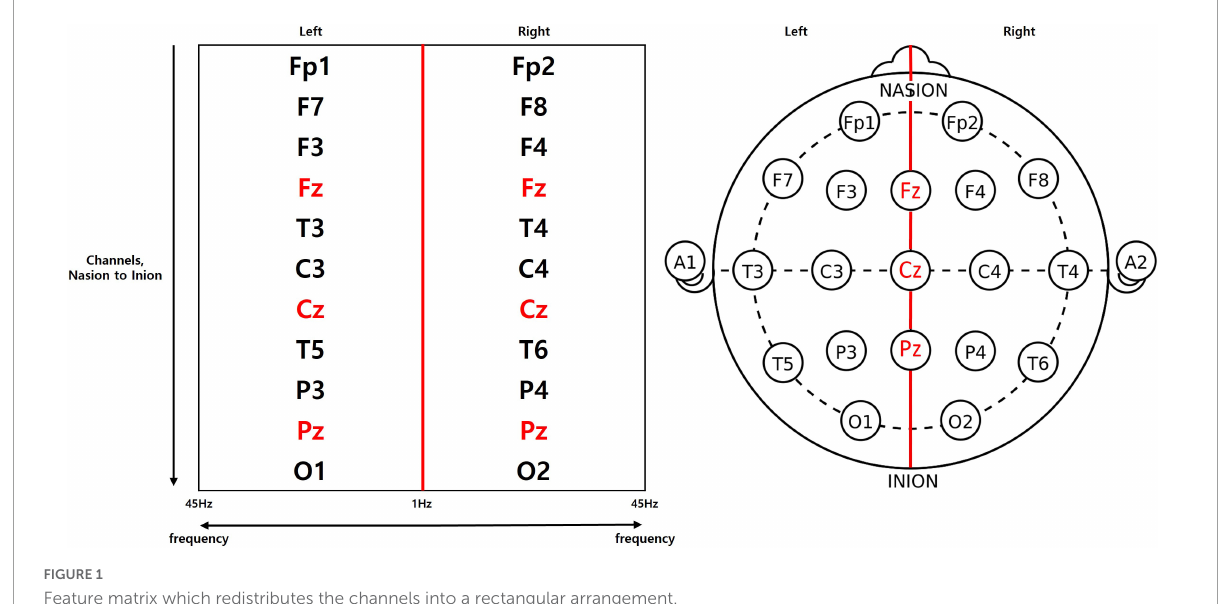
FIGURE1 Feature matrix which redistributes the channels into a rectangular arrangement.